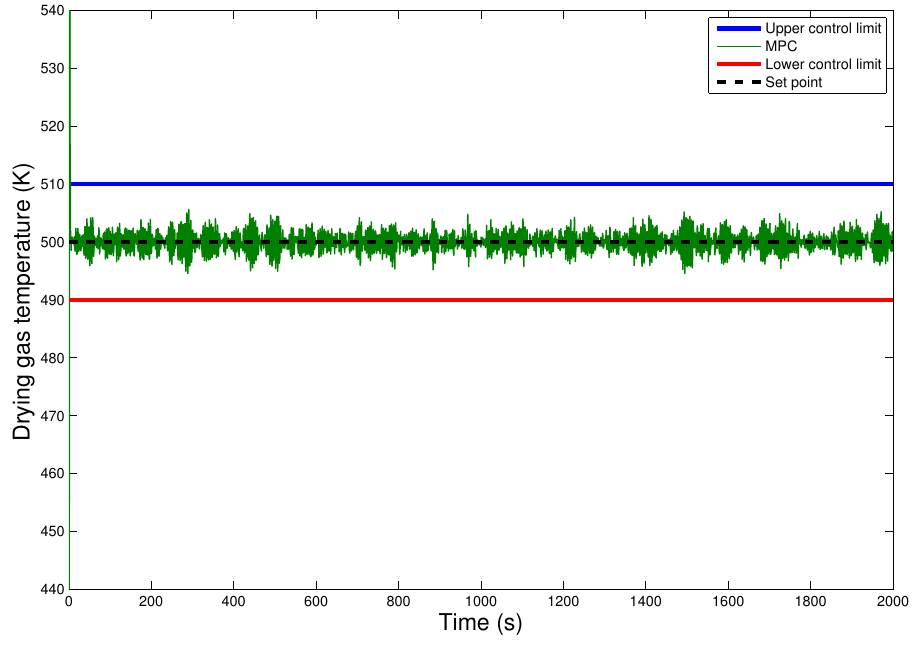
Figure 4. Hybrid MPC-PID performance of the drying gas